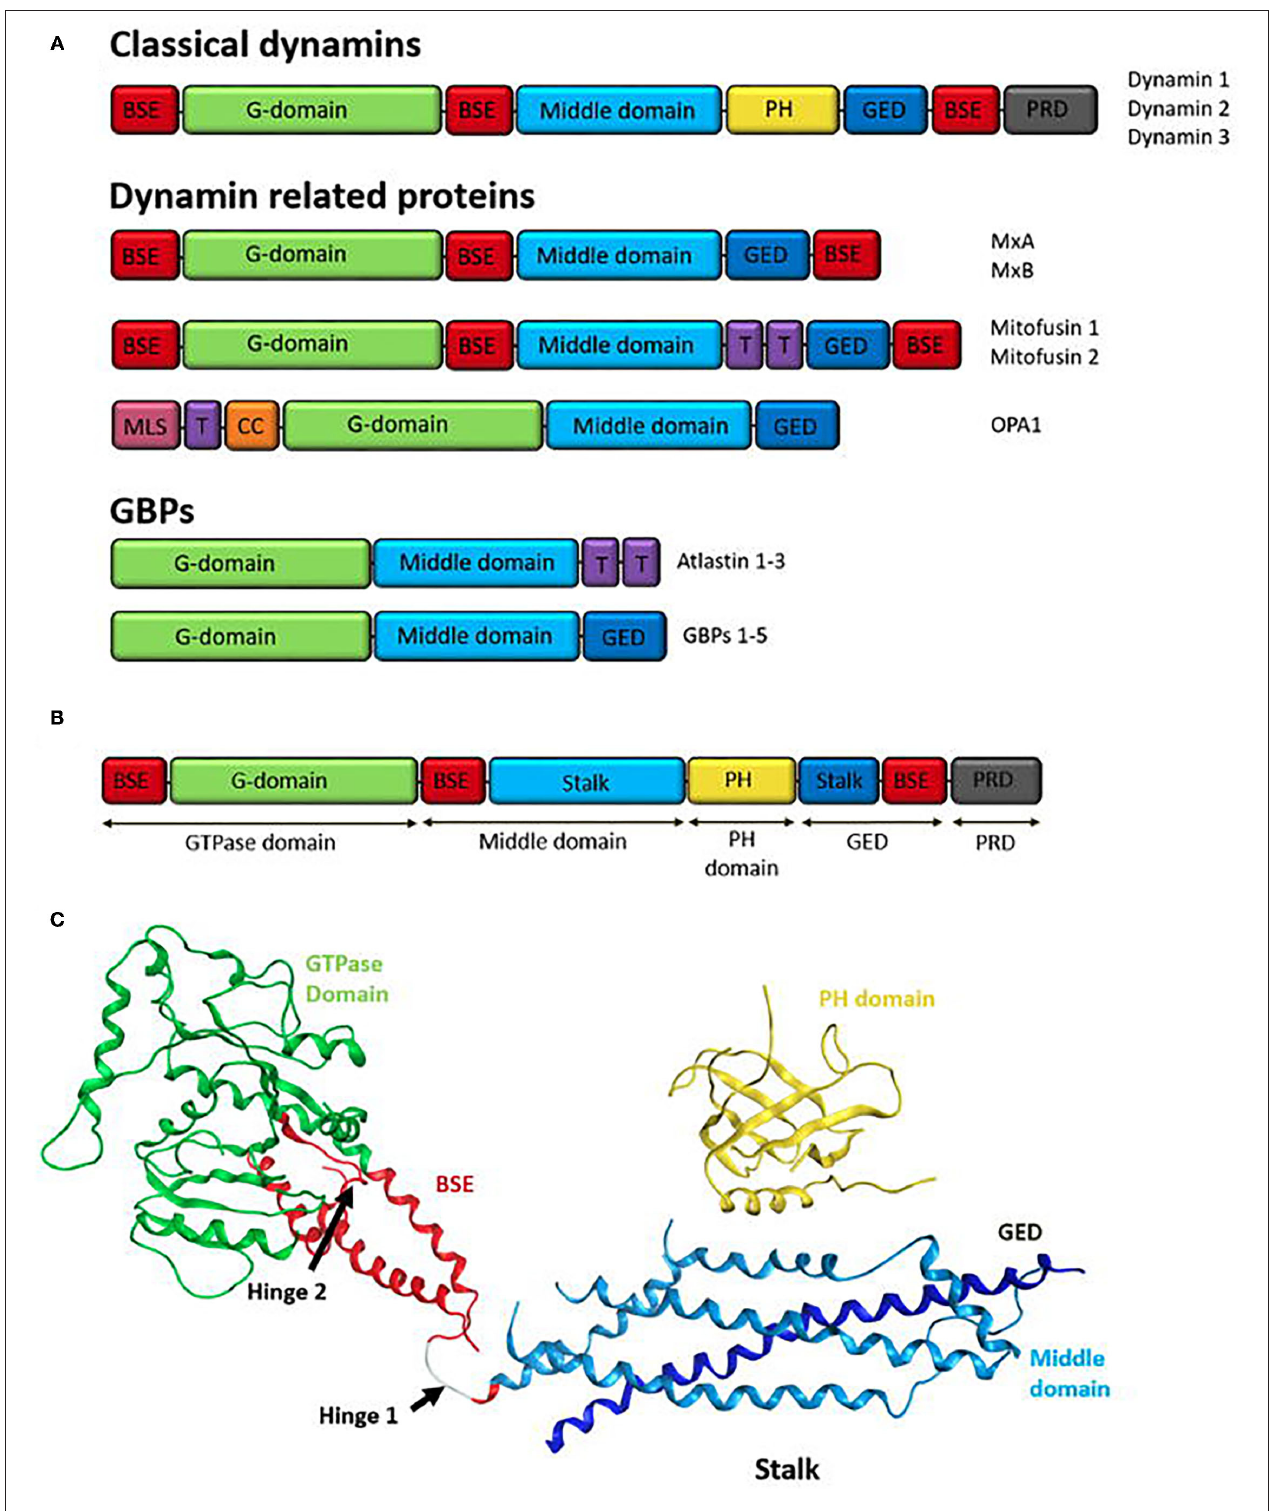
FIGURE 2 | (A) Domain structure of the human dynamin superfamily. All DSPs contain a GTPase domain, a middle domain (MD), and a GTPase effector domain (GED). The MD and GED comprises the stalk region of the dynamin structure. Additionally, most dynamins contain a domain for interactions with lipid membranes, such as a pleckstrin-homology (PH) domain or trans membrane domain (T). Classical dynamins contain a PH domain and also a C-terminal proline-rich domain (PRD).